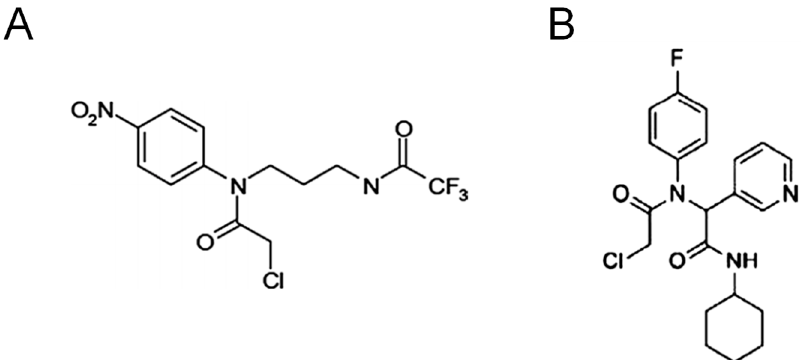
Figure 4. Structure of covalent inhibitors that specifically bind to the active site of Glutathione S-transferase Omega-1 (GSTO1) protein. ( A ) ML175 and ( B ) KT53.